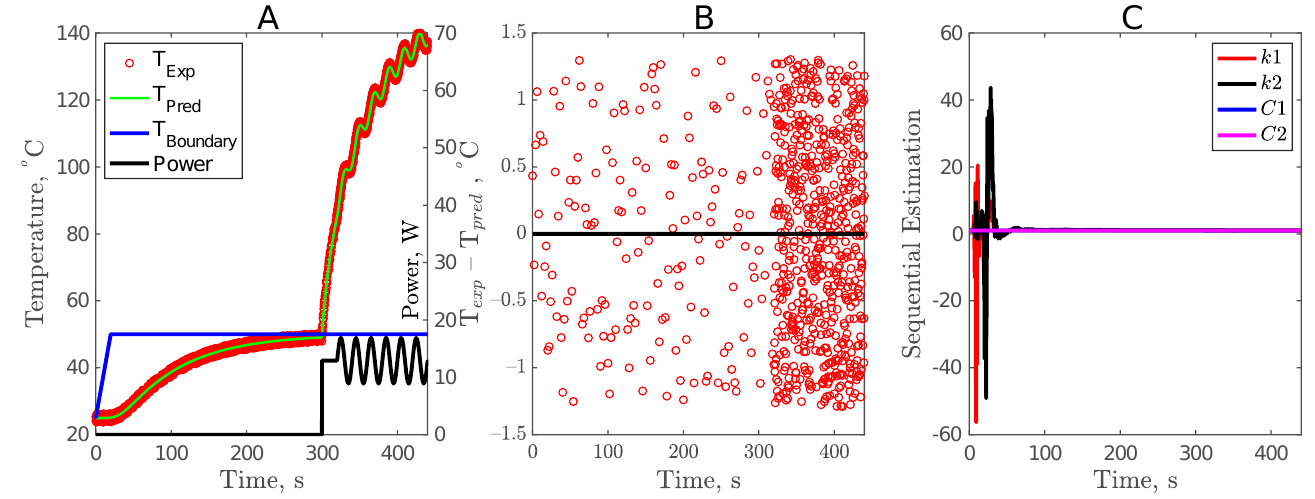
Figure 7. Inverse problem analysis and sequential parameter estimation of the optimal complemen- tary design. Table 1. Impact of experimental error ( σ ) on the estimation of temperature-dependent thermal